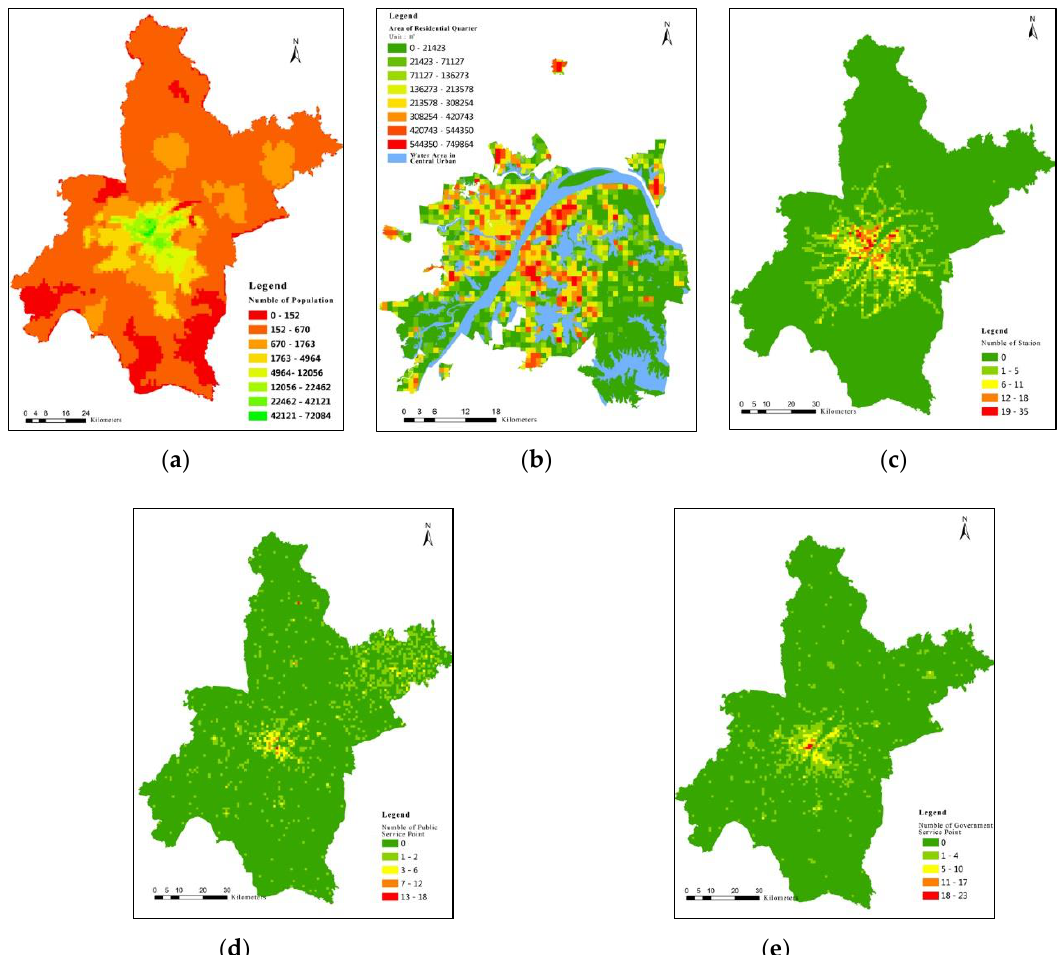
Figure 8. Thematic map of the distribution of the five influencing factors.